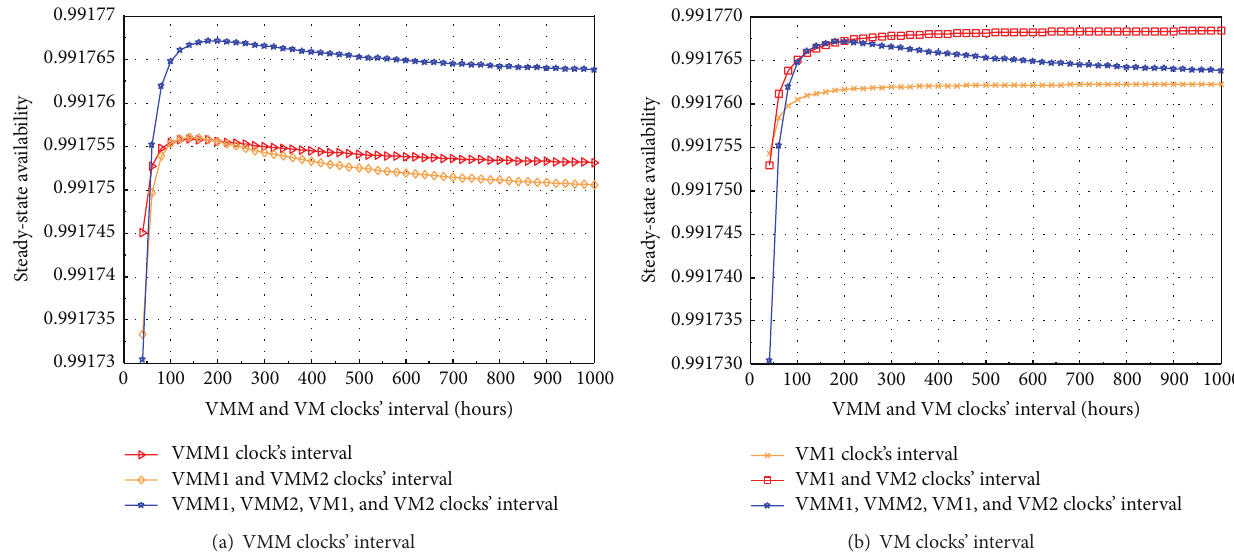
Figure 6: SSA sensitivity analysis of VM subsystem with respect to VMM and VM clocks’ interval.